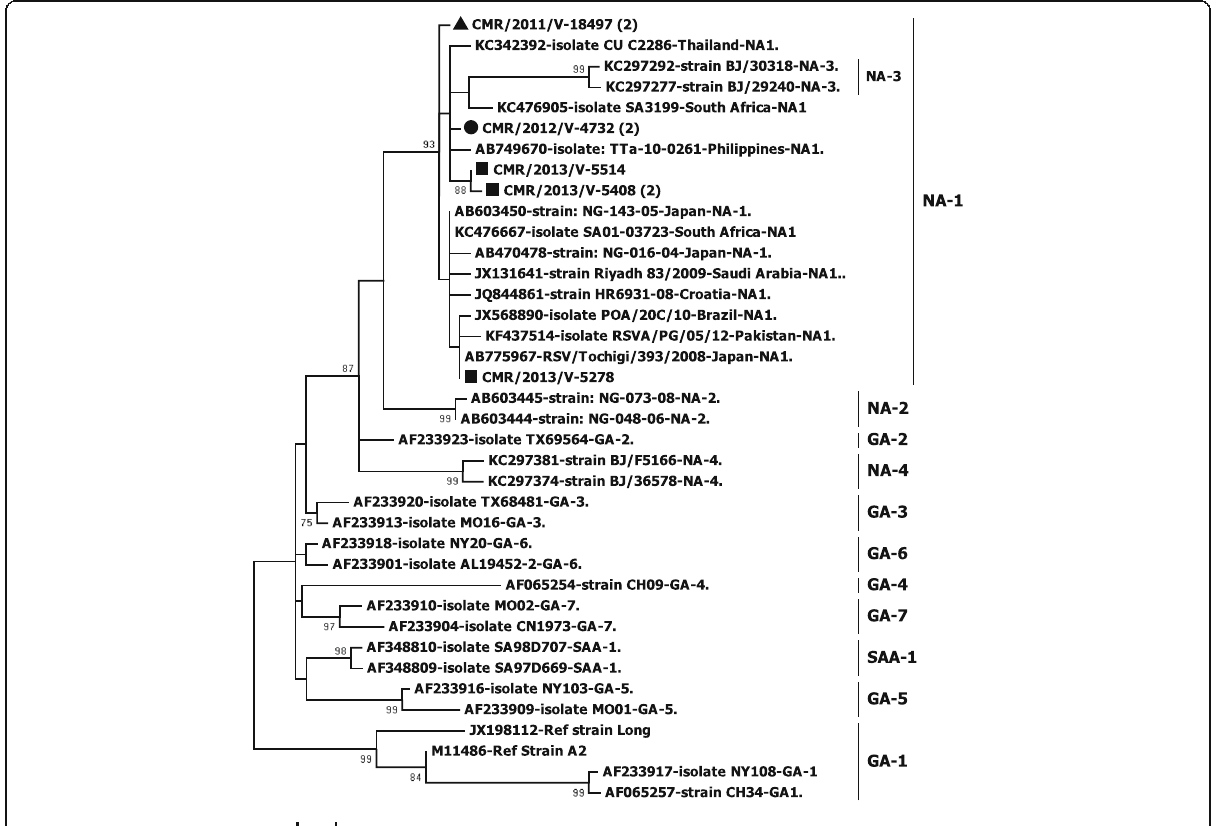
Fig. 1 Phylogenetic trees of HRSV-A strains detected in Cameroon from 2011 to 2013. Multiple sequence alignment was performed with Clustal W. The unrooted trees were generated based on nucleotide sequences of the C-terminal HVR2 region of the G gene using the maximum likelihood method under the Hasegawa-Kishino-Yano model with the site heterogeneity gamma model in MEGA version 6. The scale bars represent the frequency of nucleotide substitutions, and the numbers at the nodes of the branches are the values determined for the bootstrap resampling after 1000 iterations. Only bootstrap values >70% are presented. The reference sequences from different continents, obtained from GenBank, are identified from left to right with accession numbers, names of the strain, countries, and genotypes. Current study strains are identified from left to right by CMR (Cameroon), the year of detection, and the laboratory number. The sequences of Cameroon are marked with triangle, circle, and square for the year 2011, 2012, and 2013, respectively. The groups/genotypes assigned to branches are at the right after the